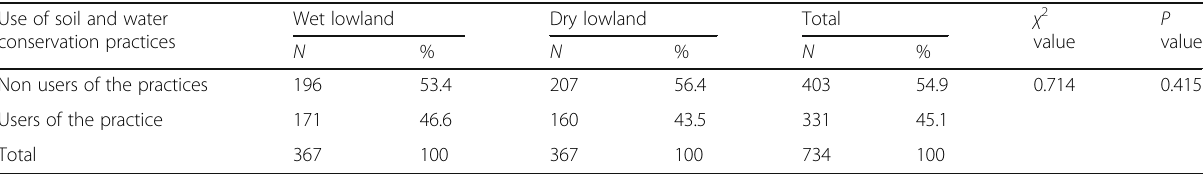
Table 4 Adaptation through soil and water conservation measures Use of soil and water conservation practices